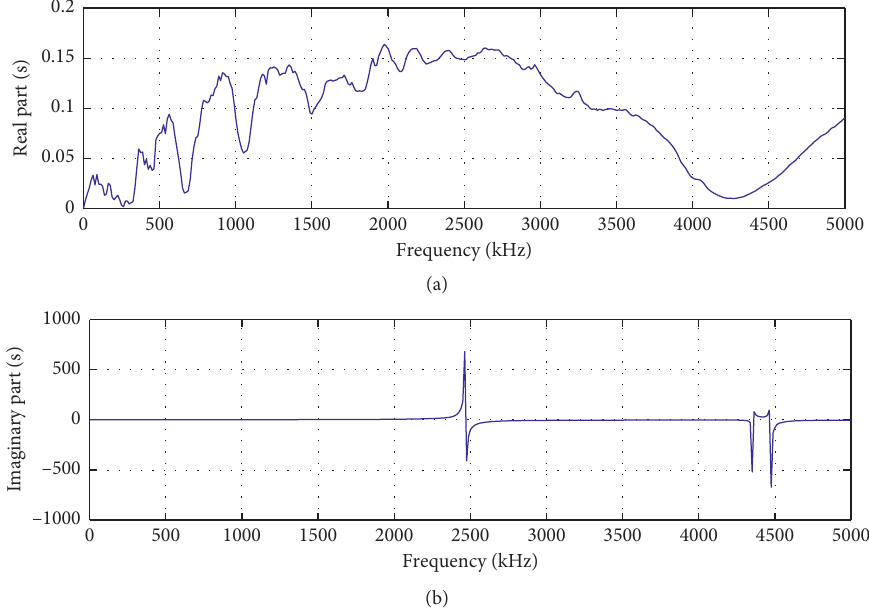
Figure 16: Scan results of the admittance for column #2.